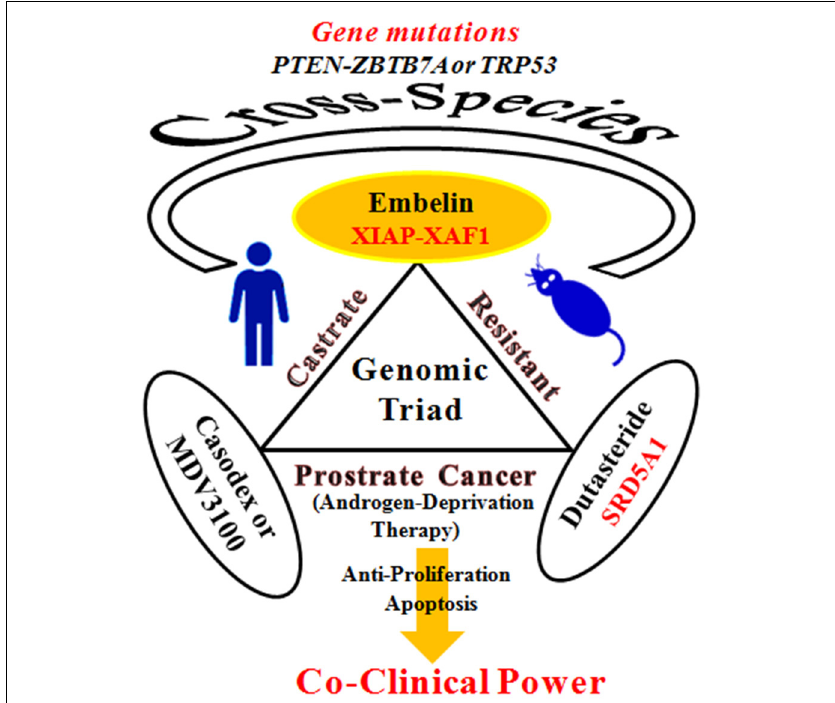
FIGURE 1 | A genomic triad with a co-clinical strategy targets for castrate-resistant prostate cancer.